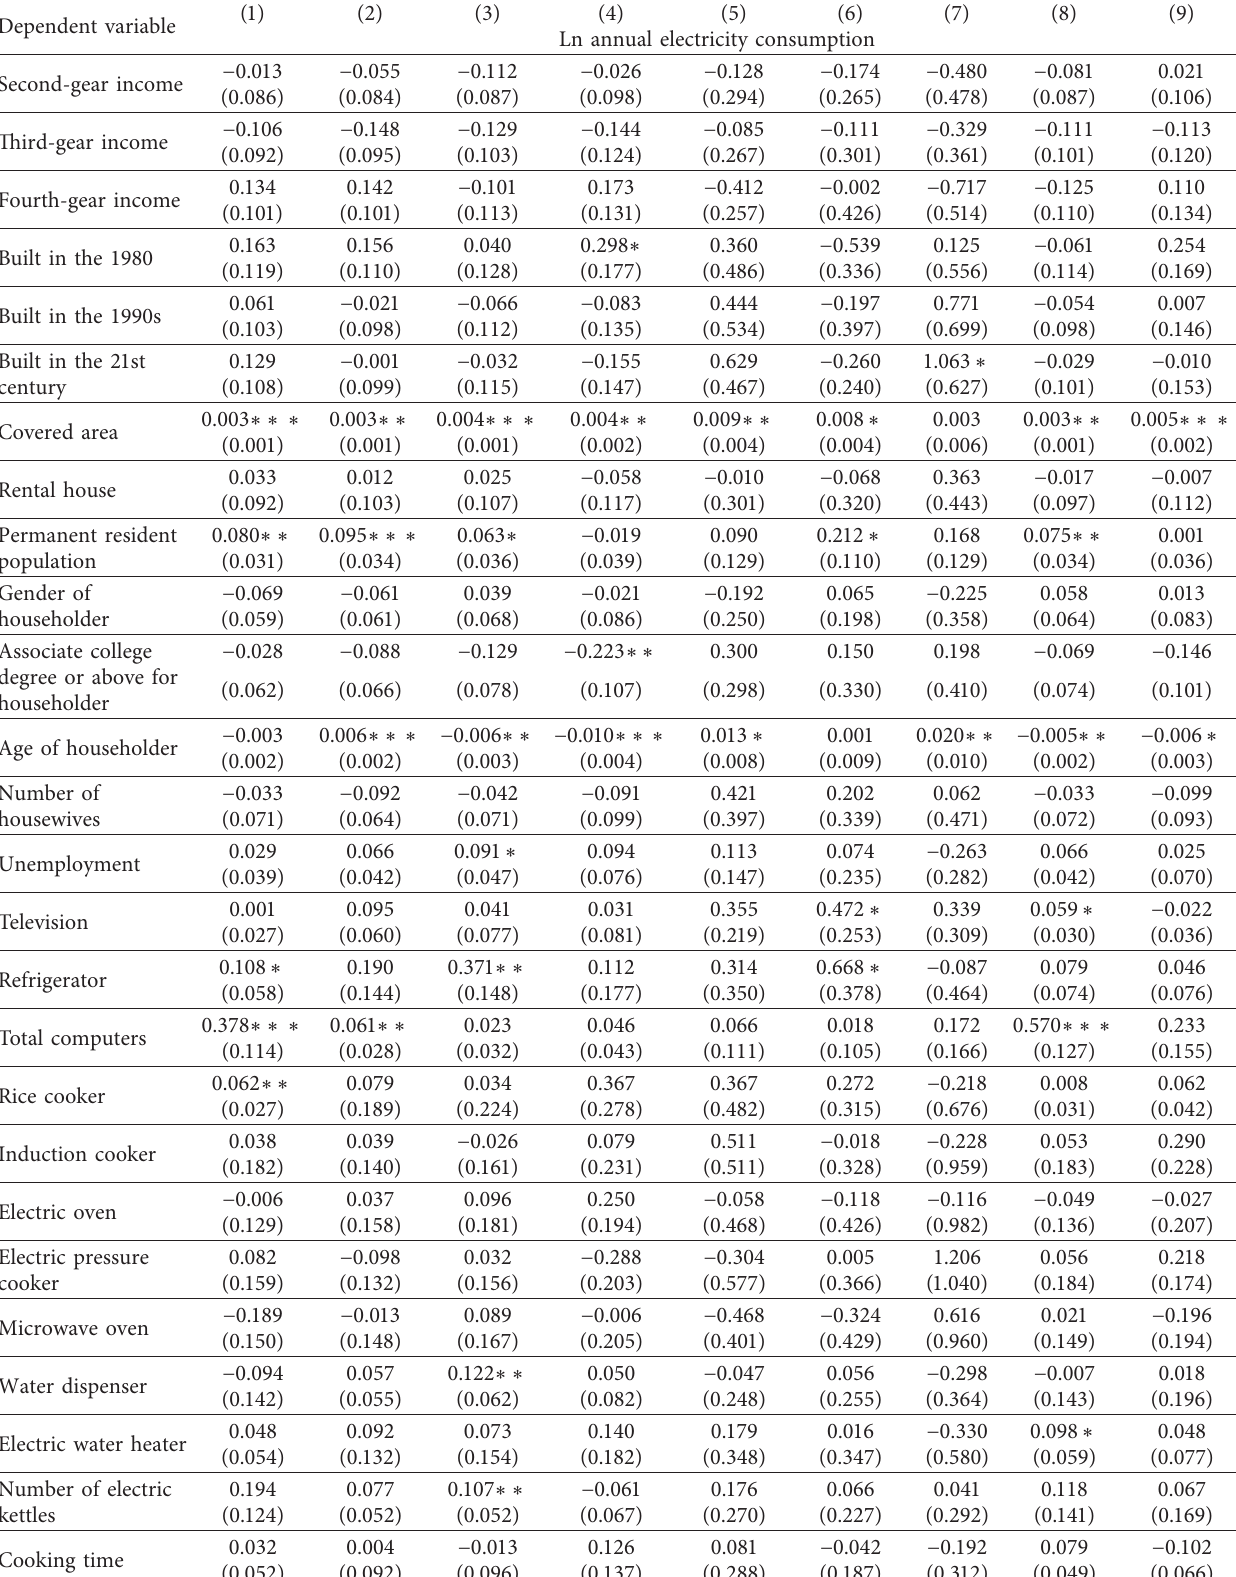
Table 3: Regression results of household annual electricity